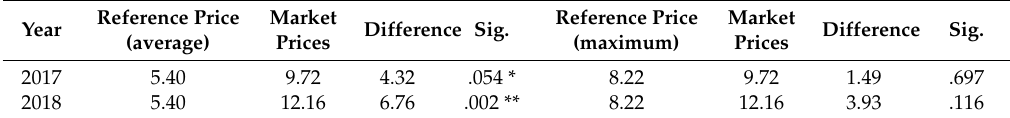
Table 3. Comparison between the land prices in 19 locations and the current reference prices in the USD.